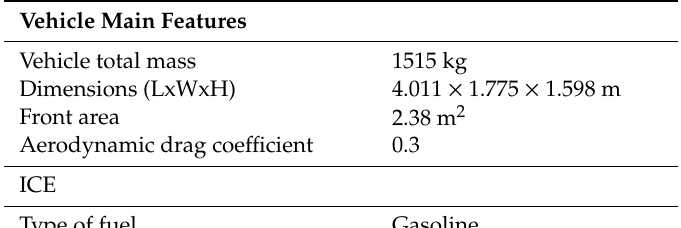
Table 23. BMW I3 main